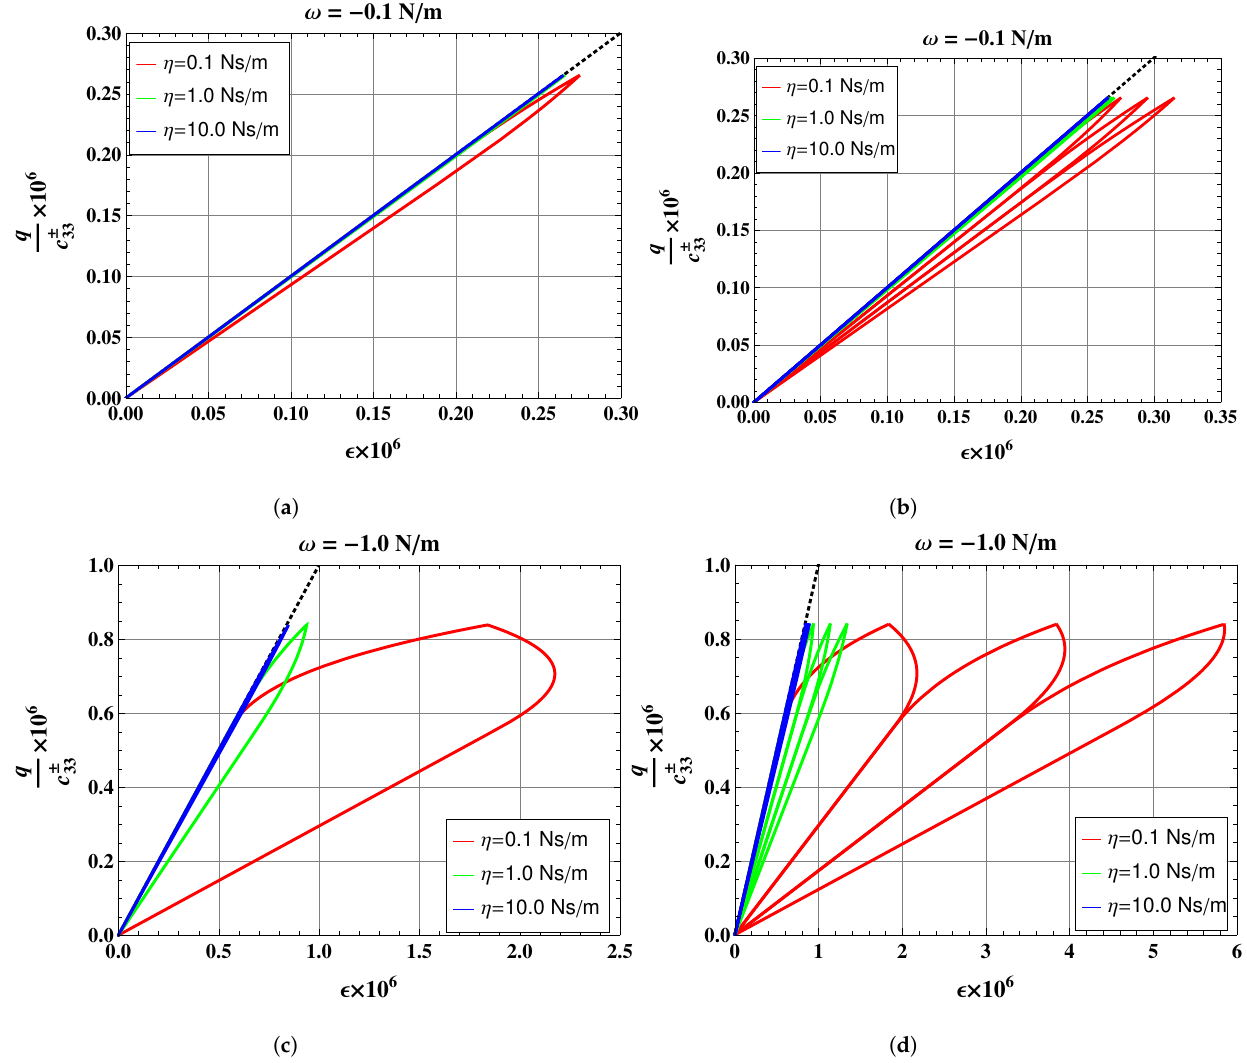
Figure 4. Normalized stress versus strain response in a single loading–unloading cycle ( a , c ) and in multiple loading–unloading cycles ( b , d ) of the layered composite depicted in Figure 2. The different plots show the effect of varying ω and η in in the damage evolution Equation (75). For comparison, normalized stress versus strain response in absence of damage (purely elastic case) is represented with a dotted